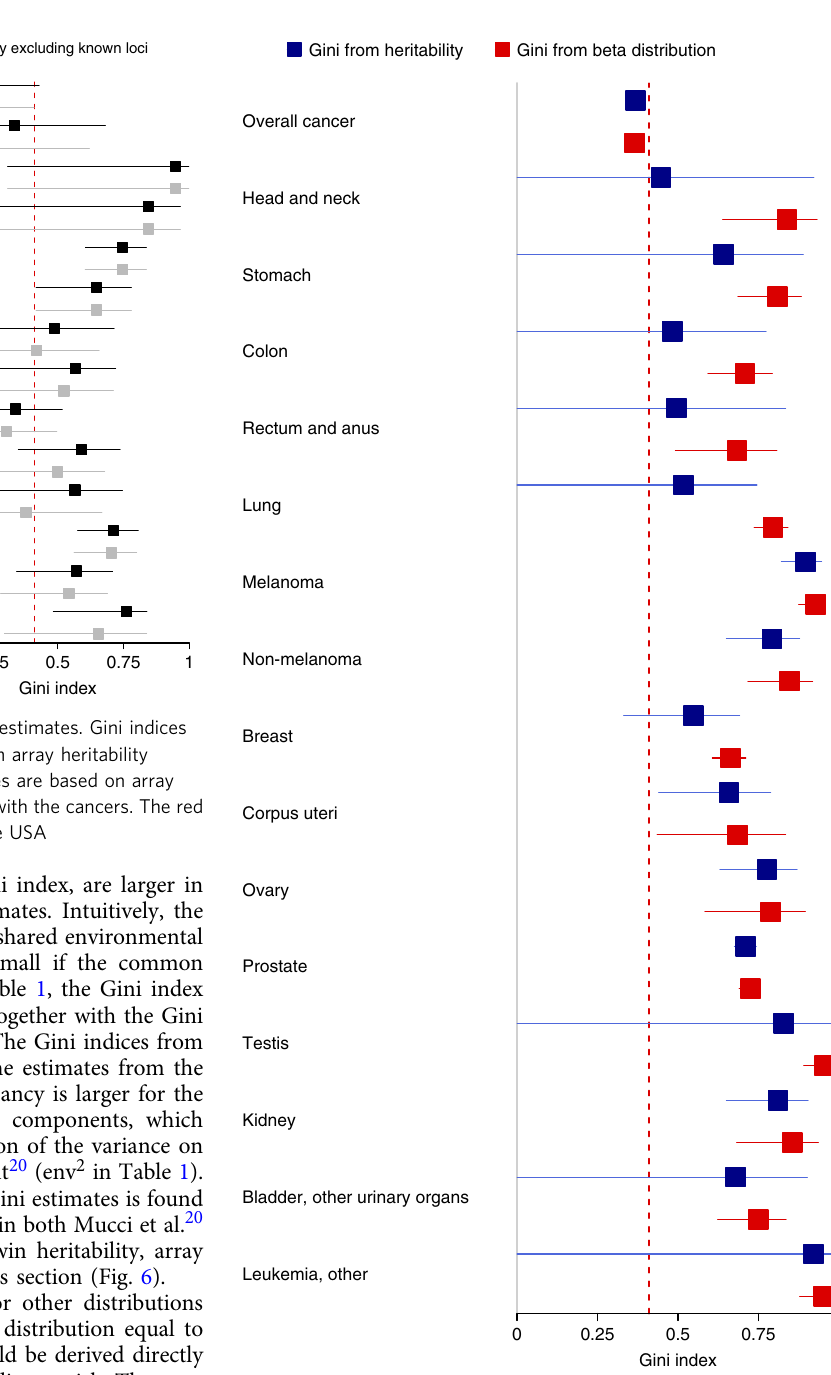
Fig. 5 Gini indices from the beta distribution. Gini indices with 95% con fi dence intervals are displayed for the twin estimates in Fig. 2 (blue) together with estimates from the alternative beta distribution (red). The red dashed line marks the Gini index of income in the